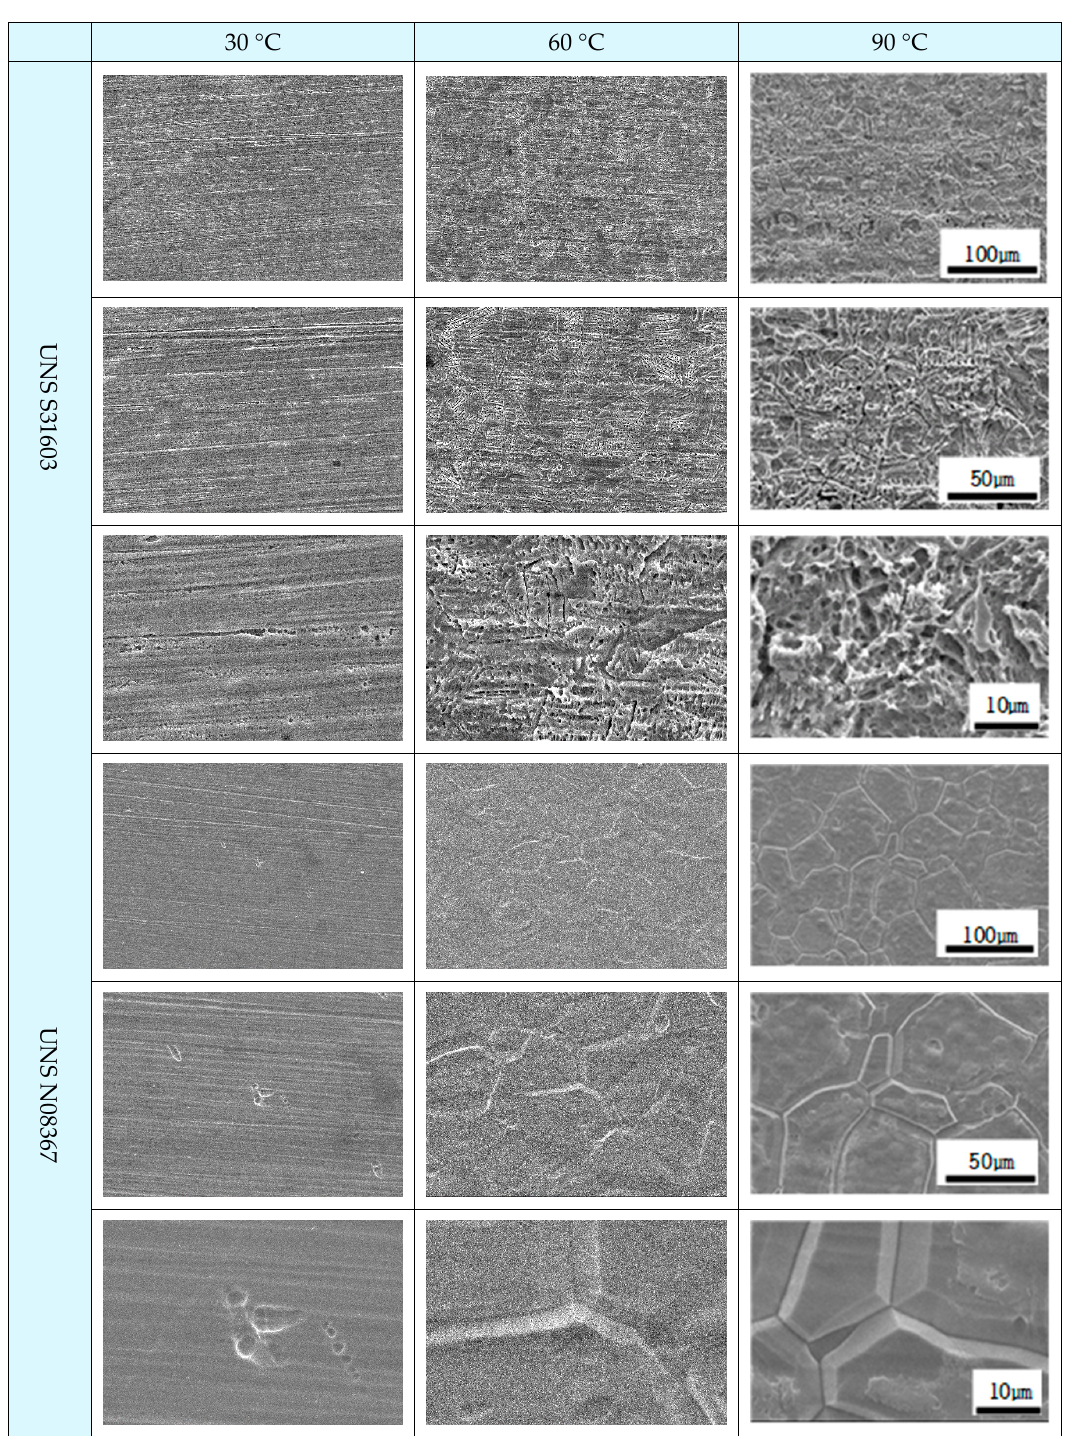
Figure 7. Surface morphologies of UNS S31603 and UNS N08367 after the electrochemical experi- ments in a modified green death solution with temperatures.